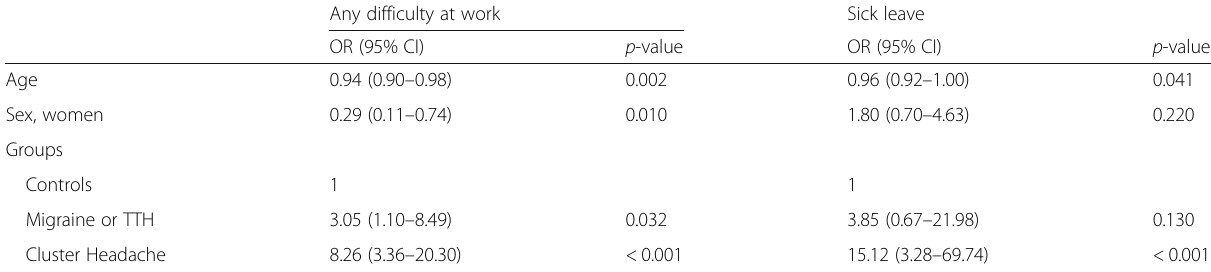
Table 3 Multivariable logistic analyses about predictors for difficulty at work and sick absence among 220 participants with current job Any difficulty at